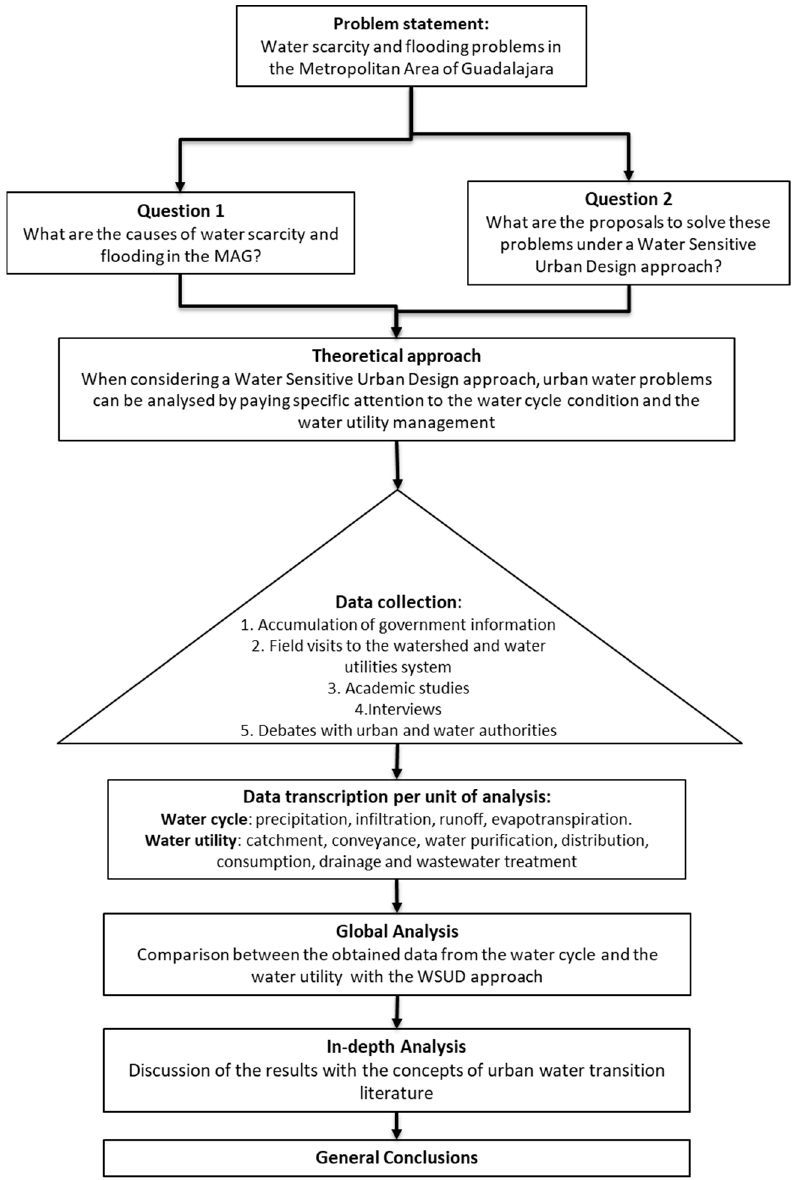
Figure 5. Methodological procedure of the study.